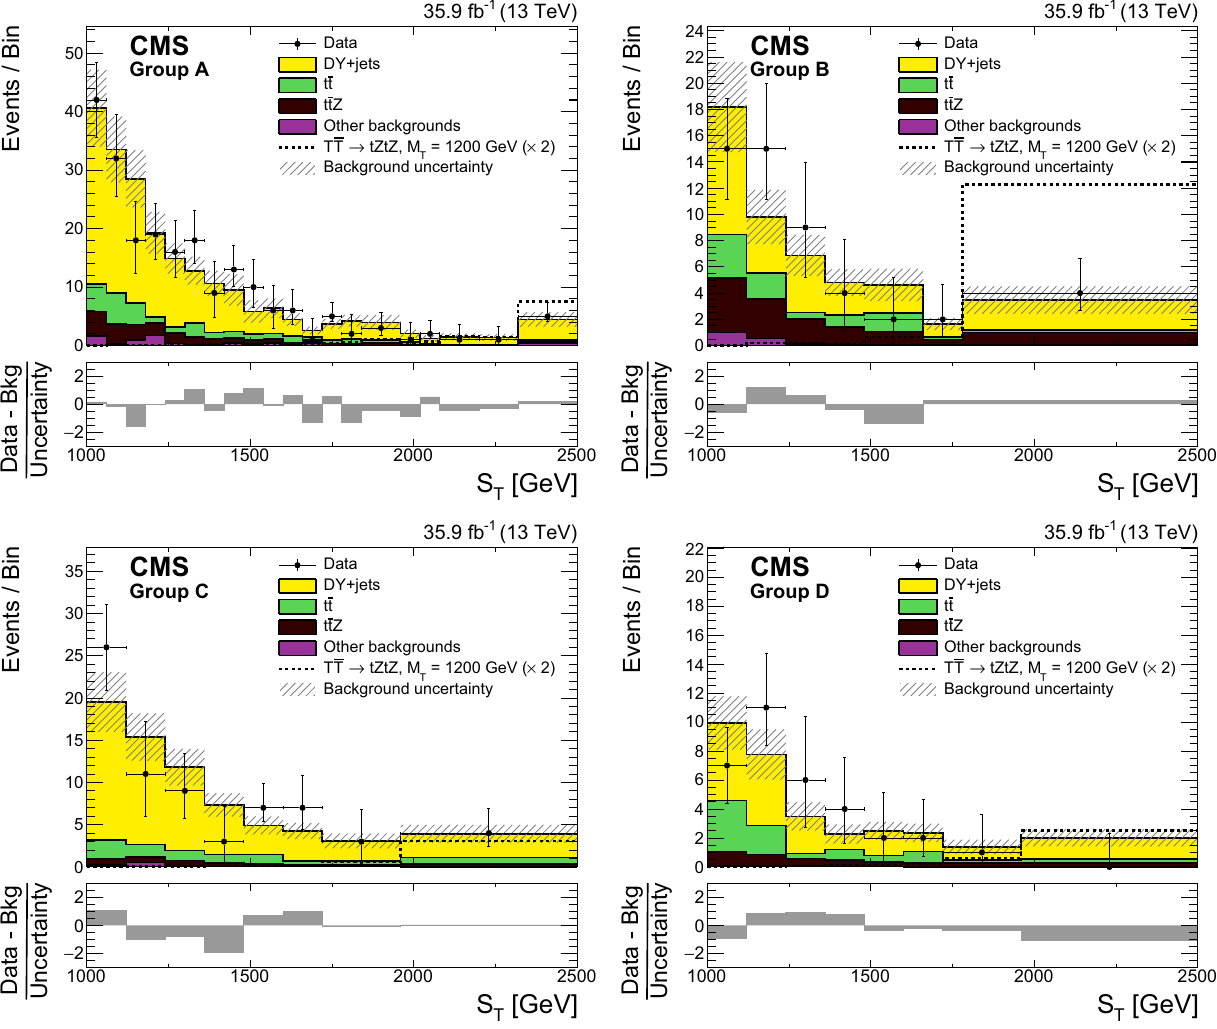
Fig. 3 The S T distributionsforgroupsA,B,C,D(lefttoright,upperto lower) from data (points with vertical and horizontal bars), the expected SM backgrounds (shaded histograms), and the expected signal, scaled up by a factor 2, for TT → tZtZ with m T = 1200GeV (dotted lines). The vertical bars on the points show the central 68% CL intervals for